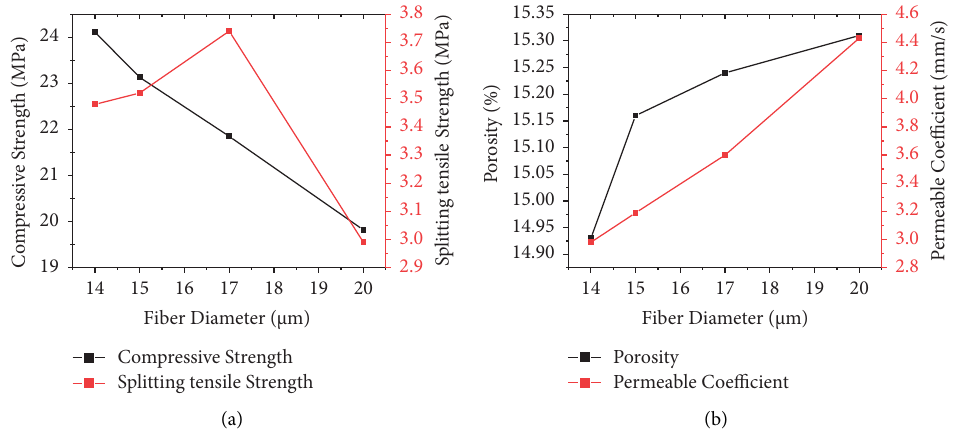
Figure 11: Line chart of infuence of diferent basalt fber diameters on pervious concrete properties. (a) Relationship between fber diameter and mechanical properties. (b) Relationship between fber diameter and water